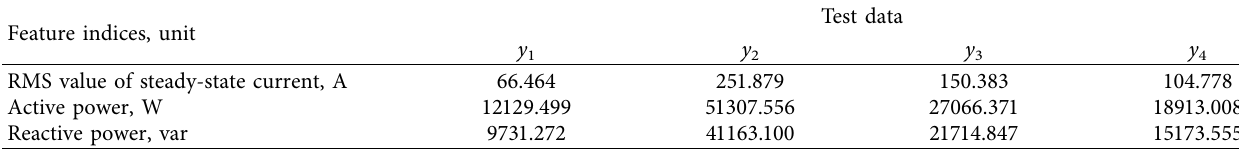
Table 6: Features of each unknown power on the bus-side.